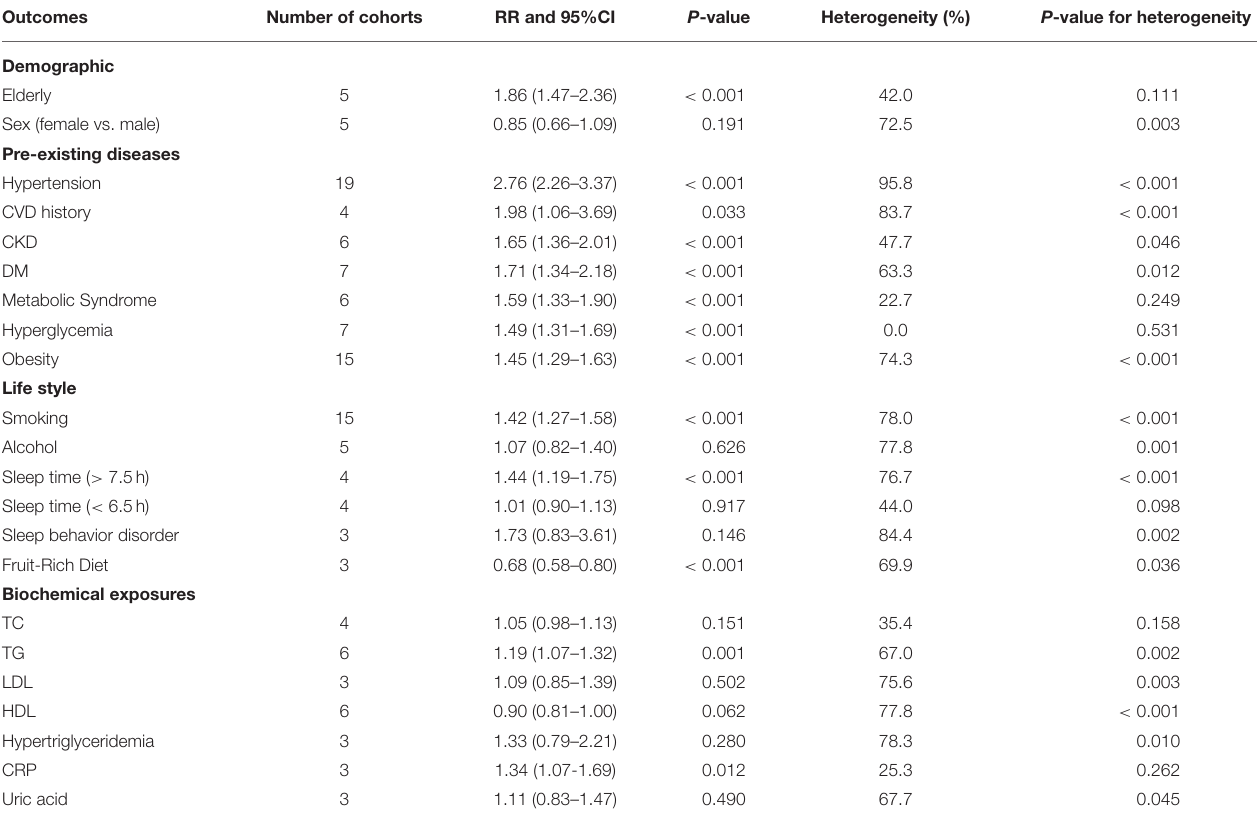
TABLE 1 | The summary results for risk factors.